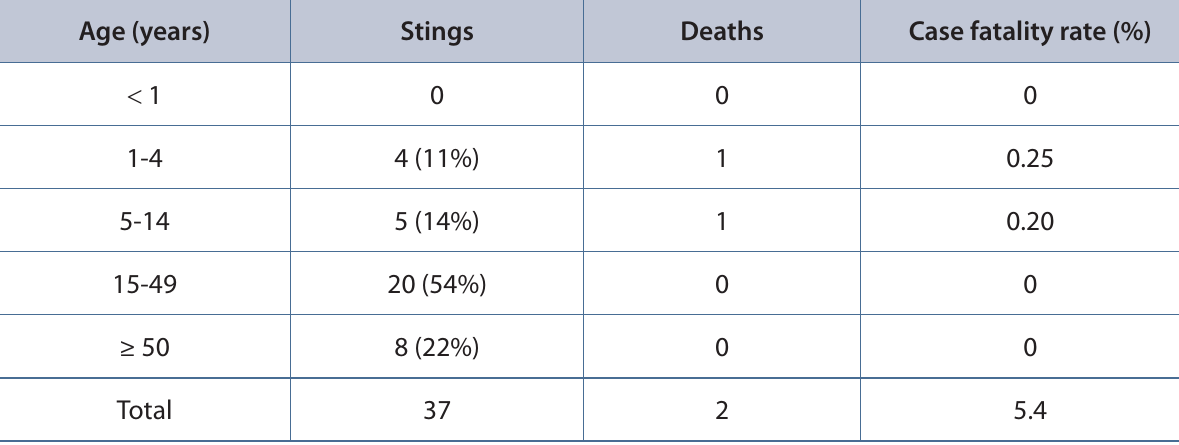
Table 1. Distribution of stings and deaths according to age Age